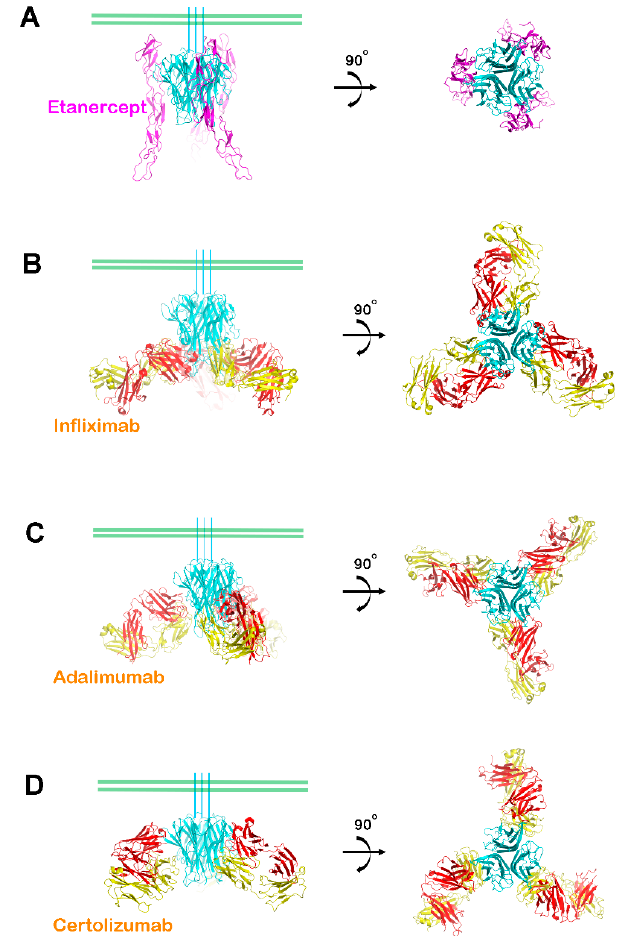
Figure 2. Overall structures of TNF α in complex with antagonists. ( A ) Ribbon representation of TNF α (cyan) in complex with the extracellular domain of TNFR2 (purple) in two orientations; ( B ) The structure of the TNF α trimer (cyan) in complex with the infliximab Fab fragment (heavy chain: red; light chain: yellow); ( C ) The structure of the TNF α trimer (cyan) in complex with the adalimumab Fab fragment (heavy chain: red; light chain: yellow); and, ( D ) The structure of the TNF α trimer (cyan) in complex with the certolizumab Fab fragment (heavy chain: red; light chain: yellow). The green bars indicate a putative membrane of a TNF α -producing cell if the TNF α trimer is a precursor form of transmembrane TNF α .